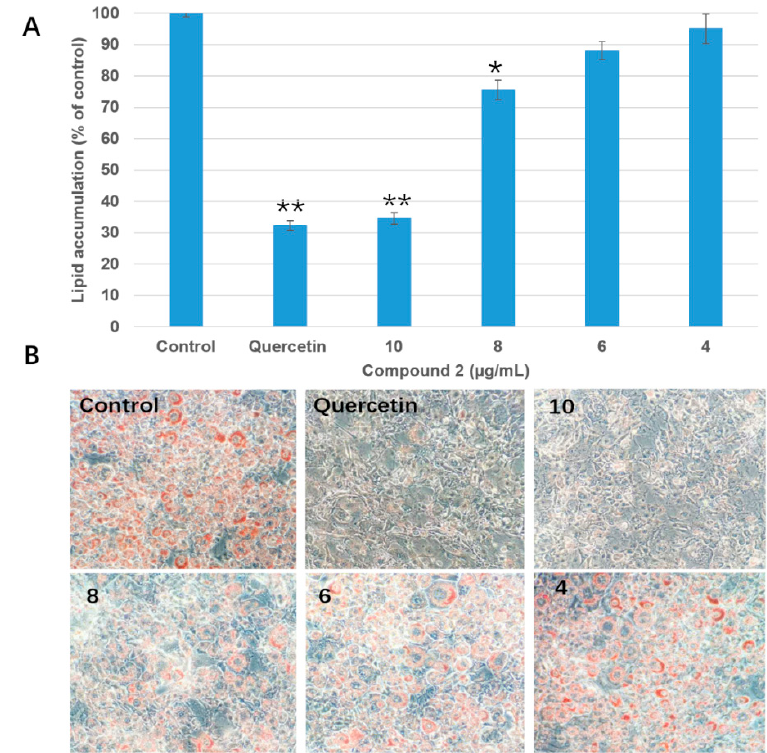
Figure 4. Inhibition of compound 2 on intracellular lipid accumulation. ( A ), Quantification of intracellular lipid using Oil Red O staining assay (* p < 0.05 vs. control, ** p < 0.01 vs. control). Data are expressed as mean ± SD (n = 3). ( B ), Images of Oil Red O staining 3T3-L1 cells after incubated with different concentrations (10, 8, 6, and 4 μ g/mL) of compound 2 taken by an Olympus IX73 microscope (Tokyo, Japan) at 200× magnification. Quercetin (50 μ g/mL) was served as a positive control.